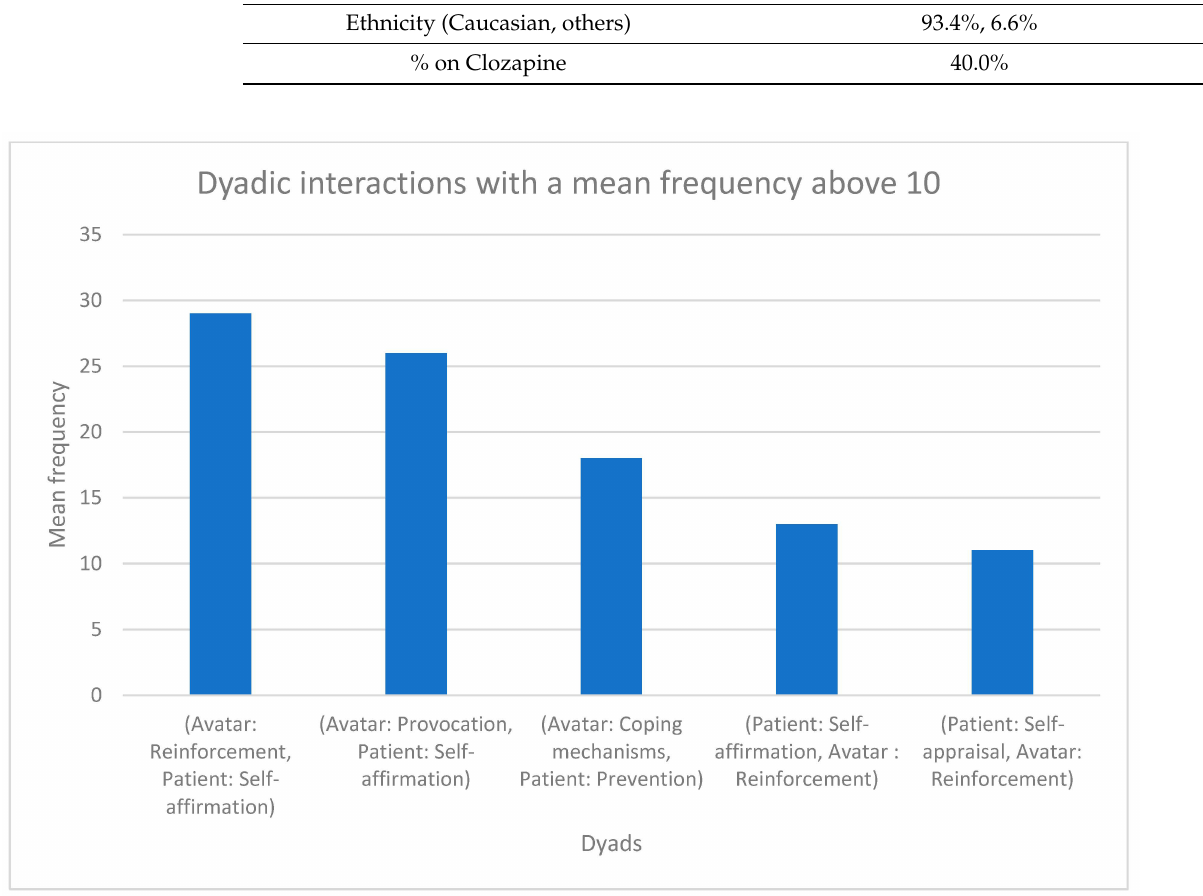
Figure 1. Dyadic interactions and their mean frequencies. Only dyads with a mean frequency per participants above 10 over the entire AT were